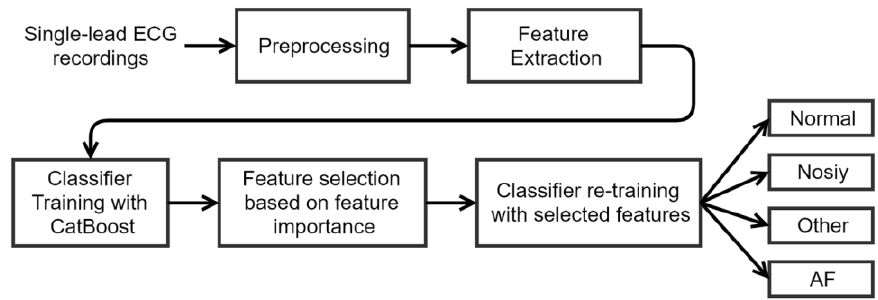
Figure 6. Flow chart of the ECG classification method proposed in this work.